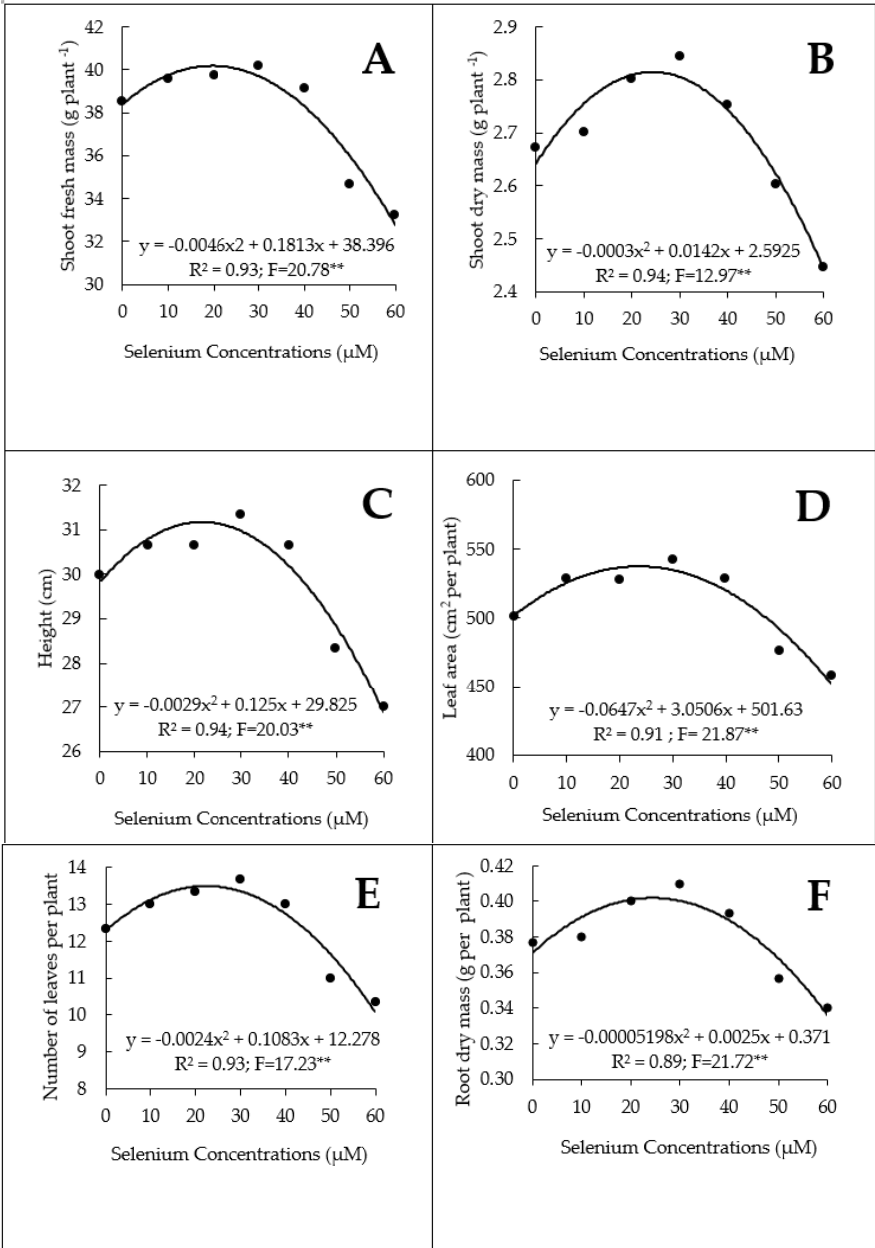
Figure 1. Shoot fresh mass ( A ), shoot dry mass ( B ), height ( C ), leaf area ( D ), number of leaves ( E ), and root dry mass ( F ) of rocket plants in response to selenium concentrations. ** Significant at p ≤ 0.01. Table 1. Adequate (Adeq.) and observed (Observ) values for leaf nutrient content in rocket plant. N P K Ca Mg S g kg − 1